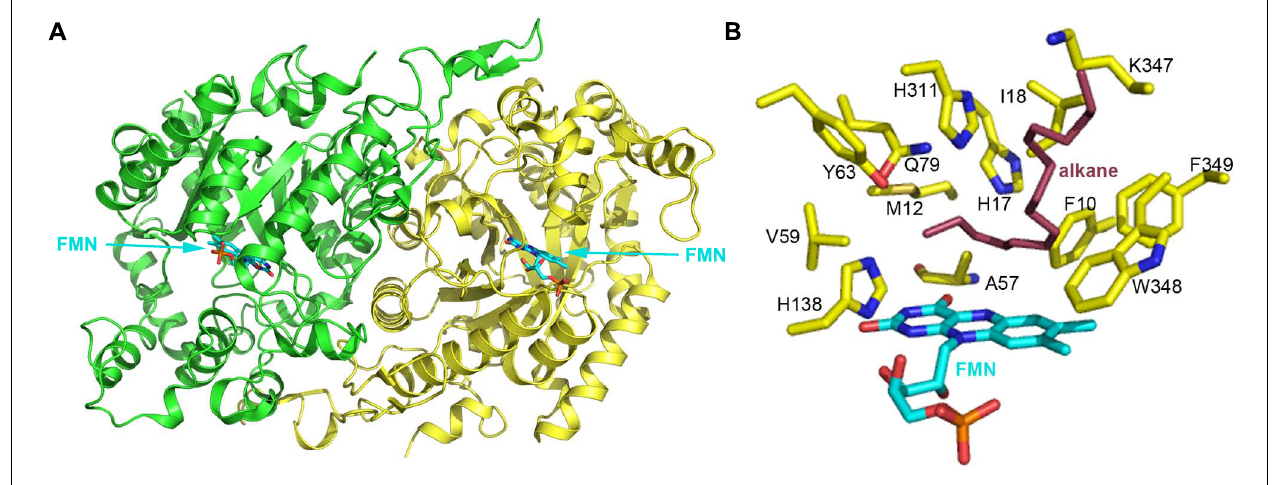
FIGURE 4 | (A) The crystal structure of long-chain alkane monooxygenase (LadA) from Geobacillus thermodenitrificans NG80-2 (Li etal., 2008).The structure is shown in cartoon representation and colored by chain, with the FMN cofactor shown in stick representation and colored cyan. (B) The putative active pocket lined by several residues above the FMN Si -face. H138 possibly acts as a proton donor in the reaction between reduced flavin and oxygen that leads to the formation of the C4a-hydroperoxyflavin intermediate. A hydrophobic cavity formed by M12, A57,V59 and the 4 (cid:2) OH